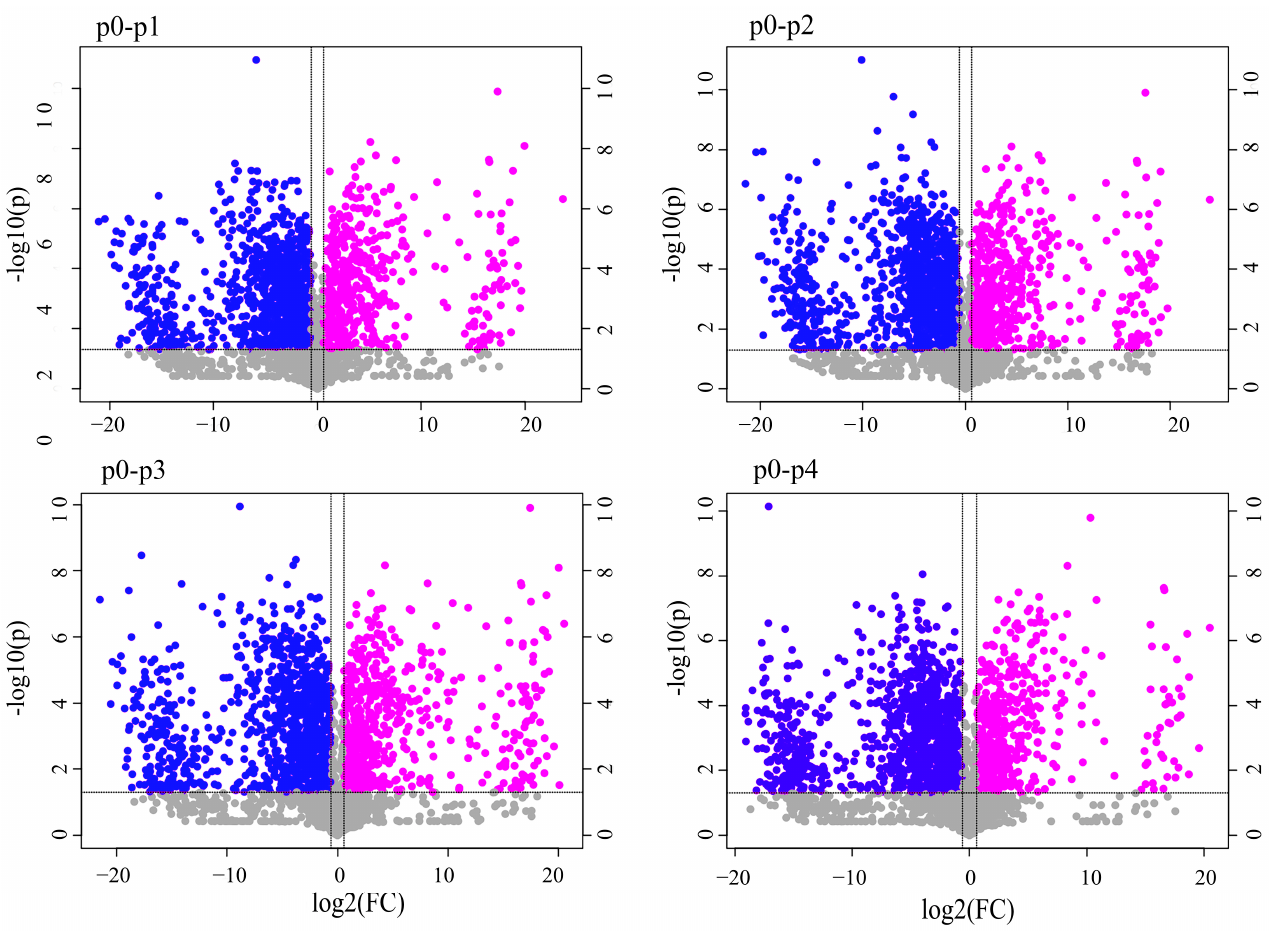
Figure 2. Volcanoes of differential metabolites with different pineapple leaf residue addition stresses.